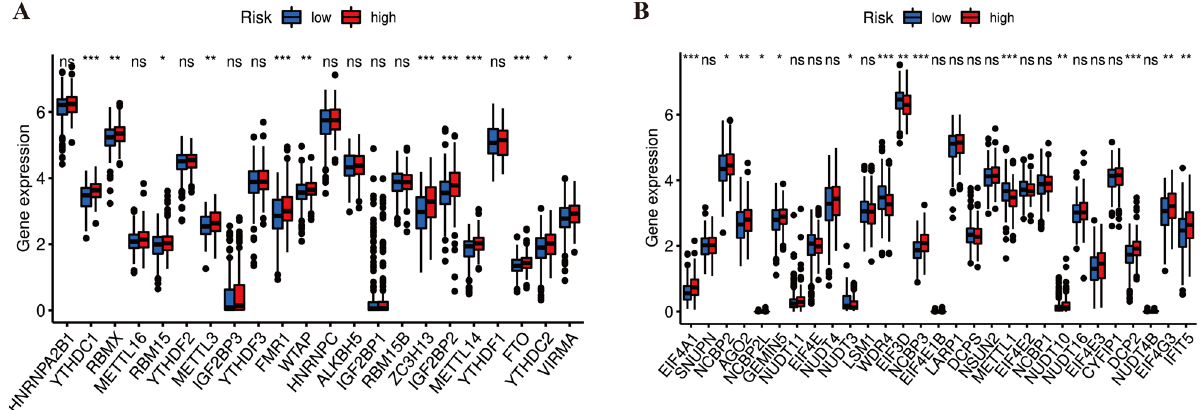
Figure 12. Methylation correlation analysis of N 6-methyladenosine (m6A) and N 7-methylguanosine (m7G) in high- and low-risk groups. ( A ) Differential expression of m6A-related genes in different risk groups. ( B ) Differential expression of m7G-related genes in different risk groups. * p < 0.05, ** p < 0.01, and *** p < 0.001.